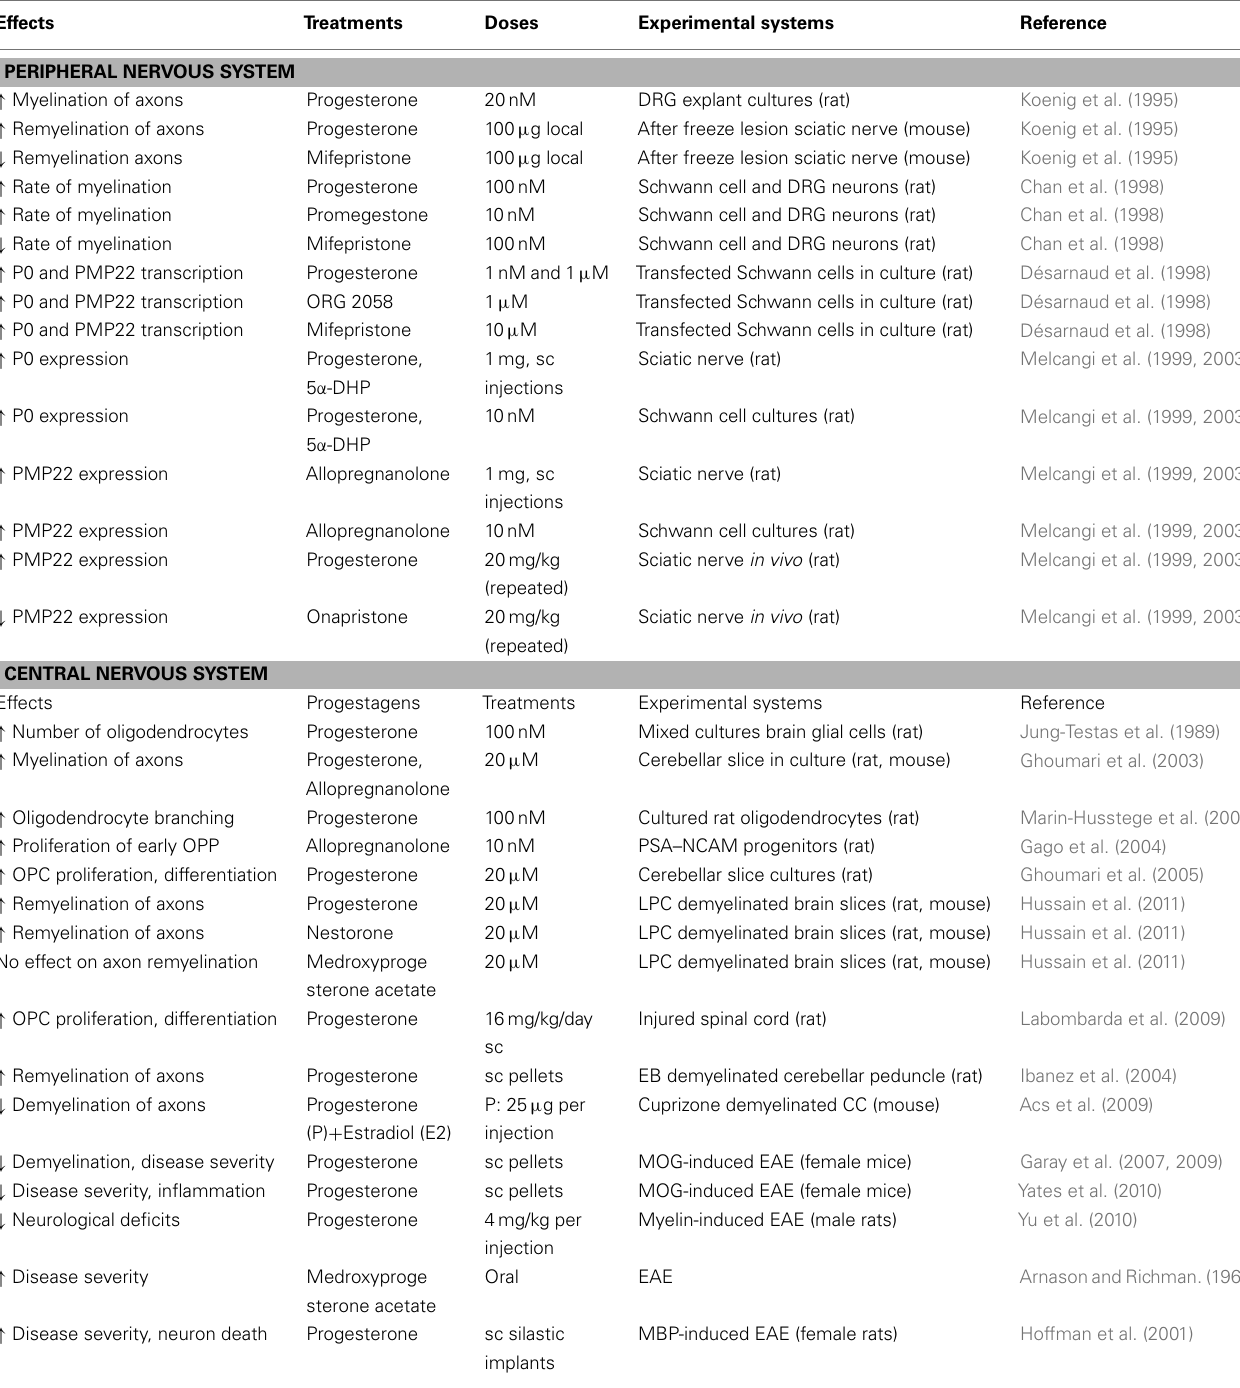
Table 1 | Effects of progestagens on